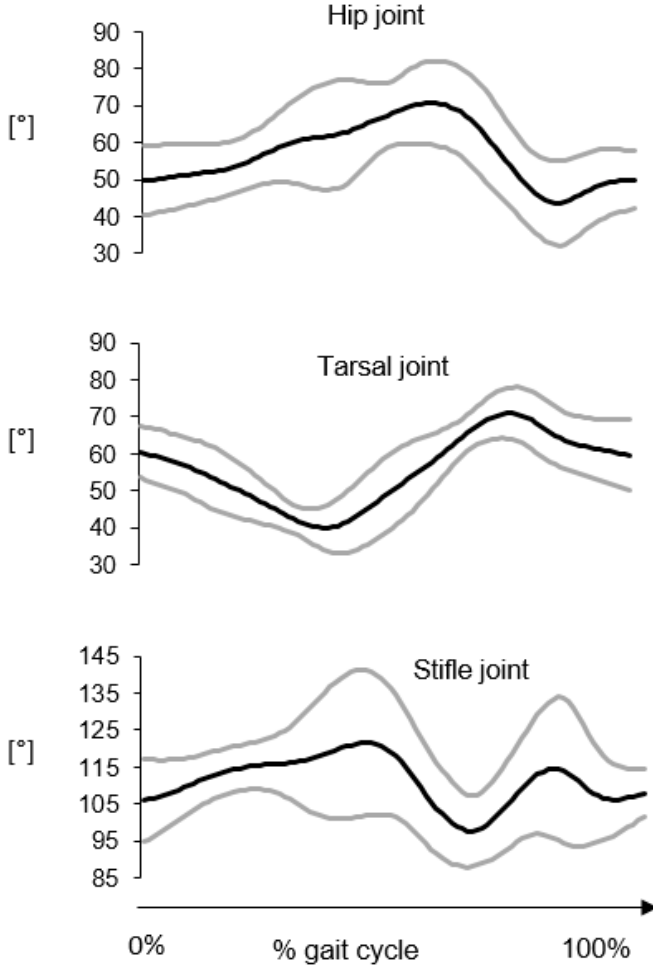
Figure 6. Hip, stifle and tarsal joint kinematics in the sagittal plane. The average curve (black line) ± the standard deviation (grey lines) were computed over six gait cycles for each subject then averaged for 8 subjects.